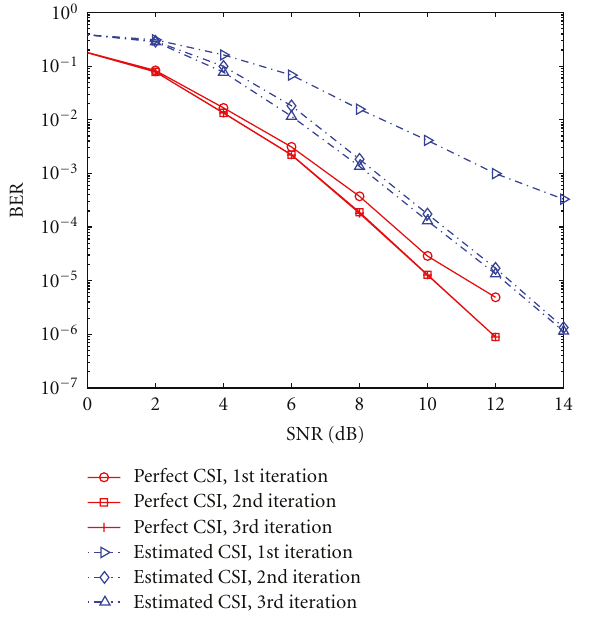
Figure 2: BER performance of OFDM systems.